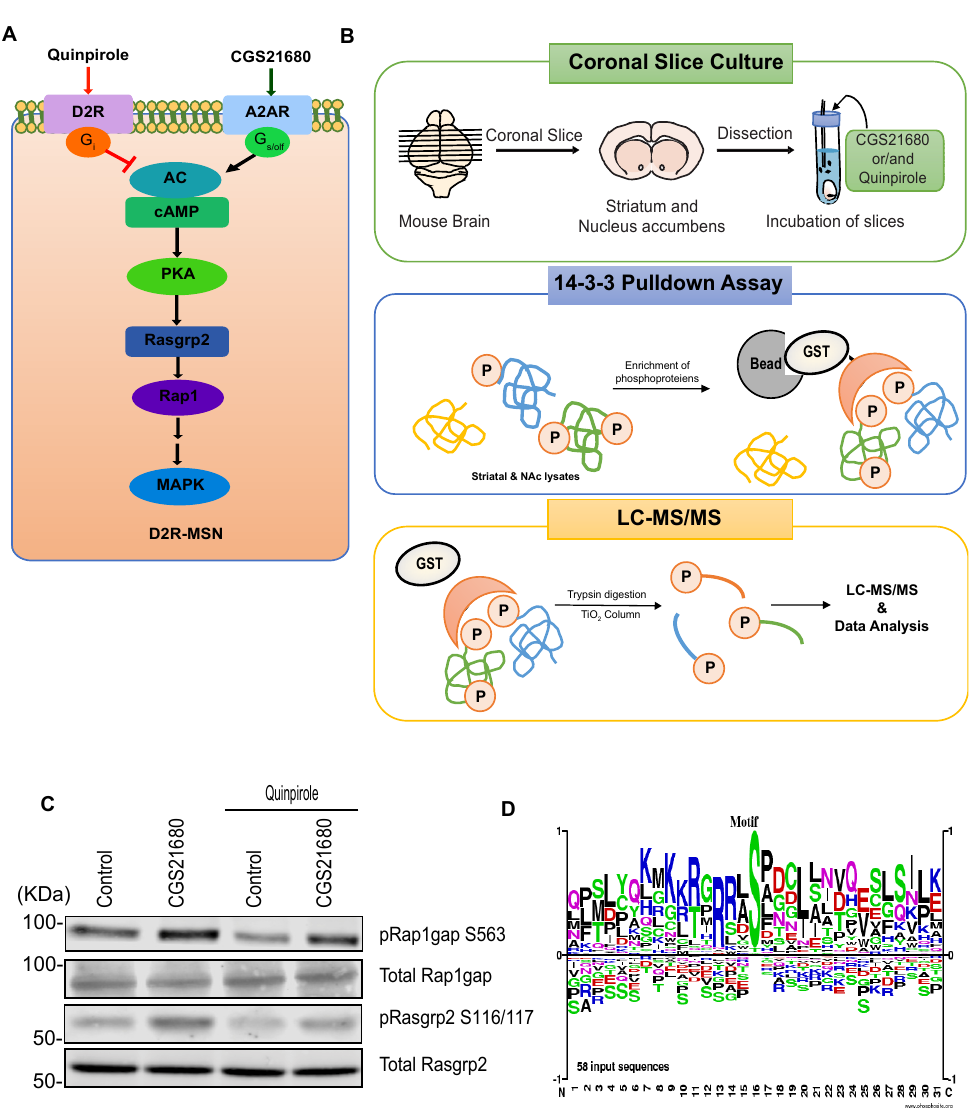
Figure 4. Identification of signaling molecules downstream of Adenosine-A2AR pathway in stria- tum/NAc. ( A ) Model of A2AR signaling pathway in D2R-MSN; ( B ) Scheme for the phosphoproteo- mic analysis used to identify candidate substrates downstream of the A2AR pathway. Striatal/ac- cumbal slices were stimulated with CGS21680 (5 μ M) for 5 min after pretreatment with quinpirole (1 μ M) for 10 min to induce A2AR-mediated phosphorylation of the phosphoprotein and then sub- jected to 14-3-3 ζ affinity chromatography followed by LC-MS/MS; ( C ) Stimulation of adenosine A2AR promotes PKA-mediated phosphorylation of Rap1gap, and Rasgrp2 in striatal/accumbal slices; ( D ) Motif analysis of the identified phosphopeptides downstream of A2AR signaling is shown.